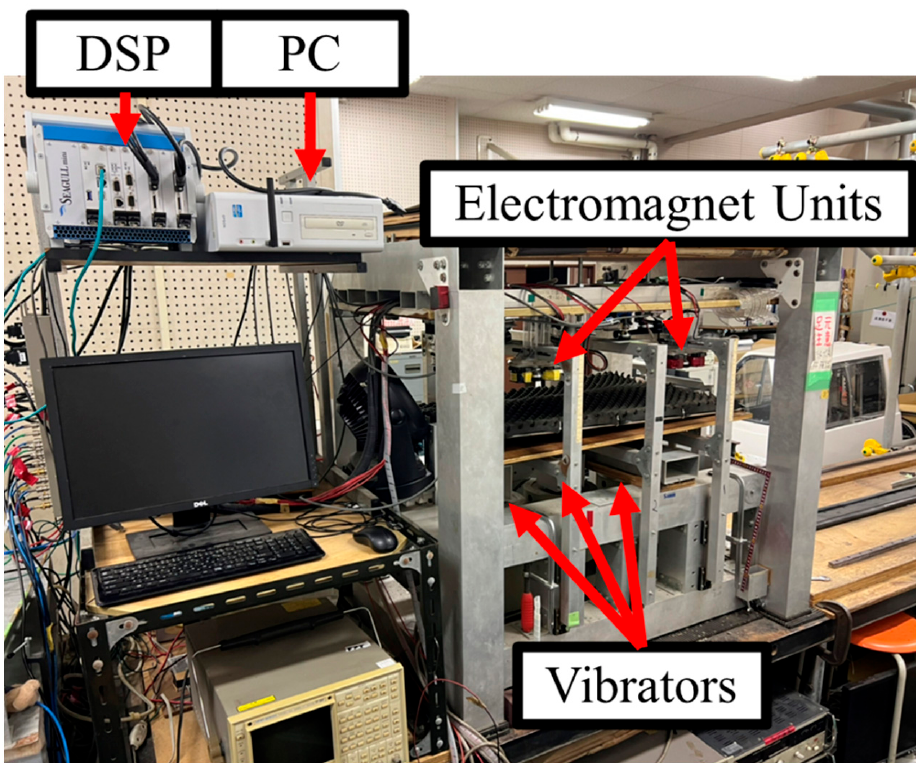
Figure 3. Photograph of the bending magnetic levitation system (overall view).